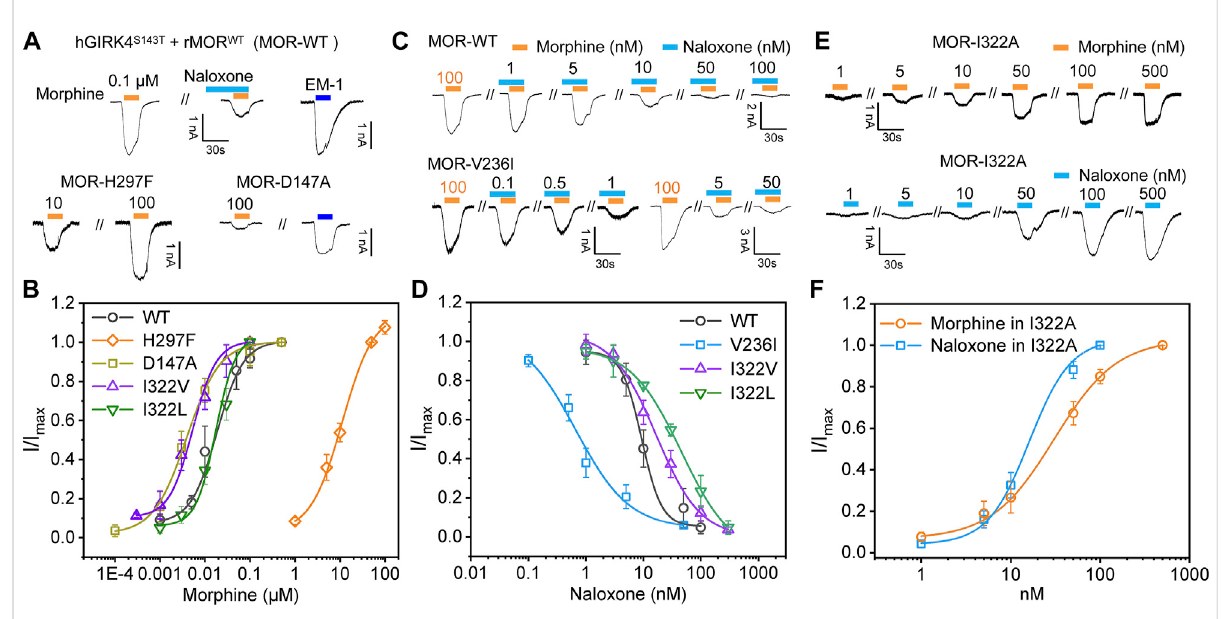
Mutagenesis carried out in key sites located at binding pocket alters the recognition and response of MOR to morphine and naloxone. (A) representative current traces for morphine (0.1 μ M) and endomorphin-1 (EM-10.1 μ M) -induced currents in HEK293 cells with co-expression of hGIRK4 S143T channels and wild type (WT) MOR, or MOR mutations, respectively. Morphine-induced currents can be inhibited by naloxone (0.1 μ M). (B) concentration response relationships for morphine-induced currents in HEK293 cells with co-expression of hGIRK4 S143T channels and WT MOR, or MOR mutations, respectively. (C,D) representative current traces (C) and concentration response relationships (D) in cells with co- expression of hGIRK4 S143T channels and WT or MOR V236I induced by morphine and naloxone, respectively. (E,F) representative current traces (E) and concentration response relationships (F) in cells with co-expression of hGIRK4 S143T channels and WT or MOR I322A induced by morphine or naloxone, respectively. Eachpointrepresentsthemean±SEofatleast3independentmeasurements.Solidlinesare fi ttedwiththe Hill1 equation formorphine and naloxone-induced currents in WT or MOR I322A ,